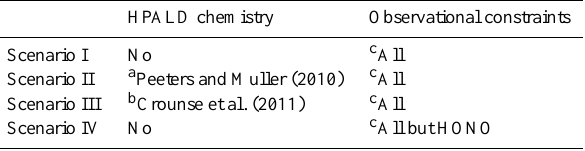
Table 3. A summary of critical differences in input parameters for four different model simulation scenarios presented in this study. The isoprene chemical scheme is based on Archibald et al. (2010a).